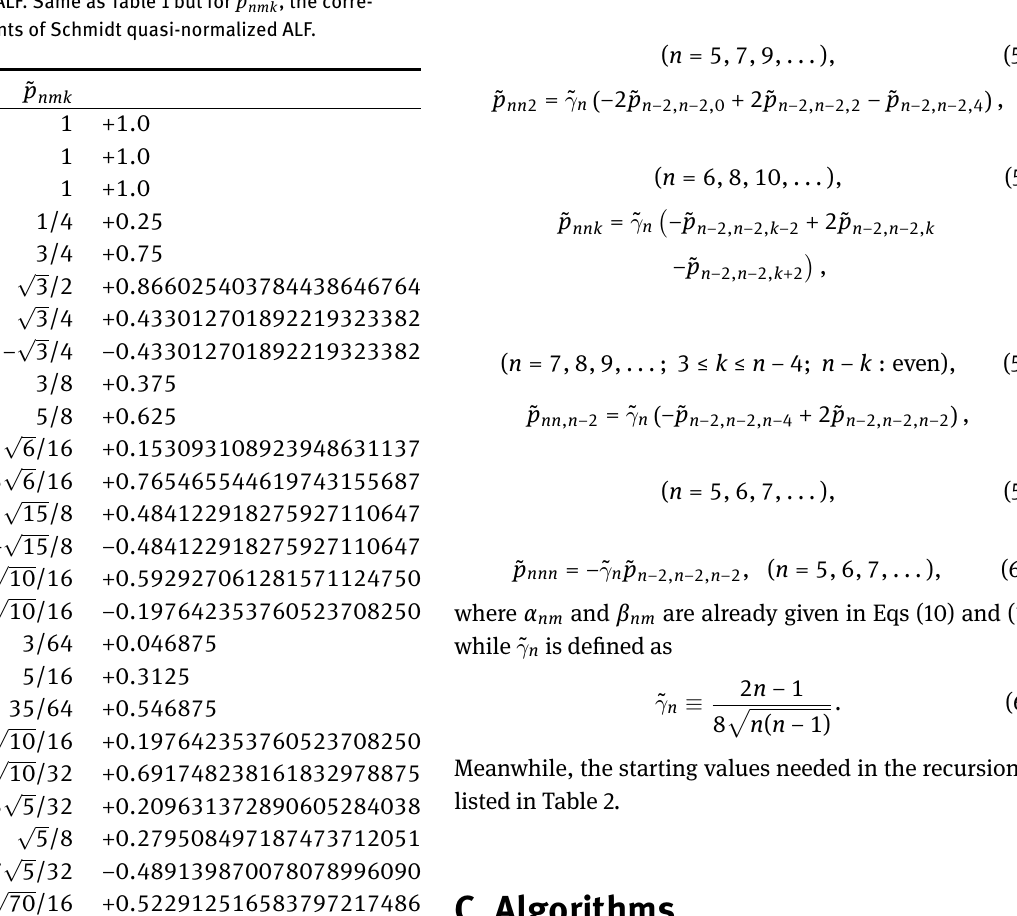
Table 2: Sample values of sine/cosine series coefficients of Schmidt quasi-normalized ALF. Same as Table 1 but for ˜ p nmk , the corre- sponding coefficients of Schmidt quasi-normalized